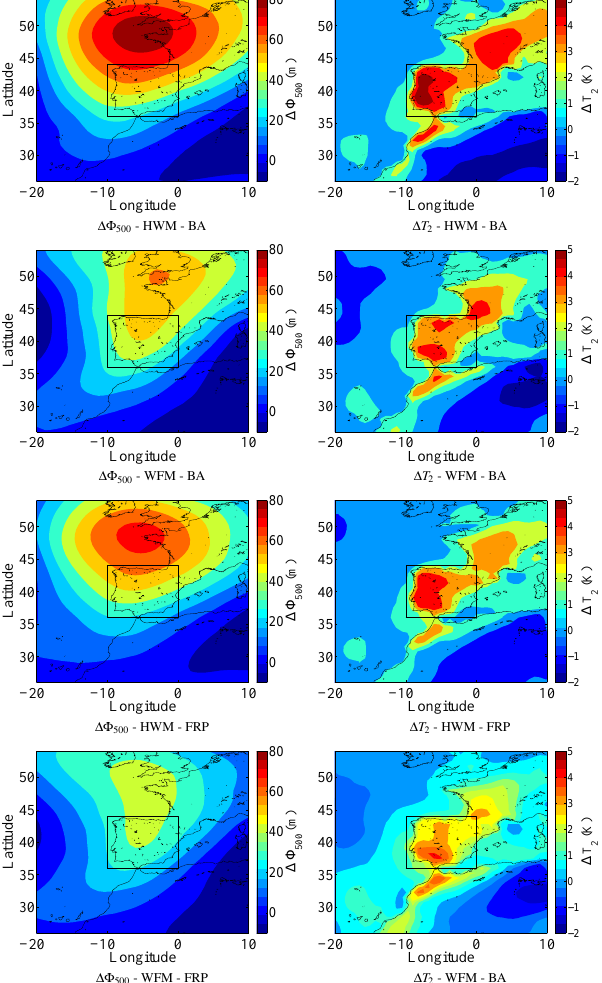
Figure 4. Composites over the Iberian Peninsula of the 500-hPa geopotential anomaly ( (cid:49)(cid:56) 500 ) (left column) and the 2m air tem- perature ( (cid:49)T 2 ) (right column) for BA diagnostic corresponding to HWM (first row from top) and WFM (second row from top) and for FRP diagnostic corresponding to HWM (third row from top) and WFM (fourth row from top).